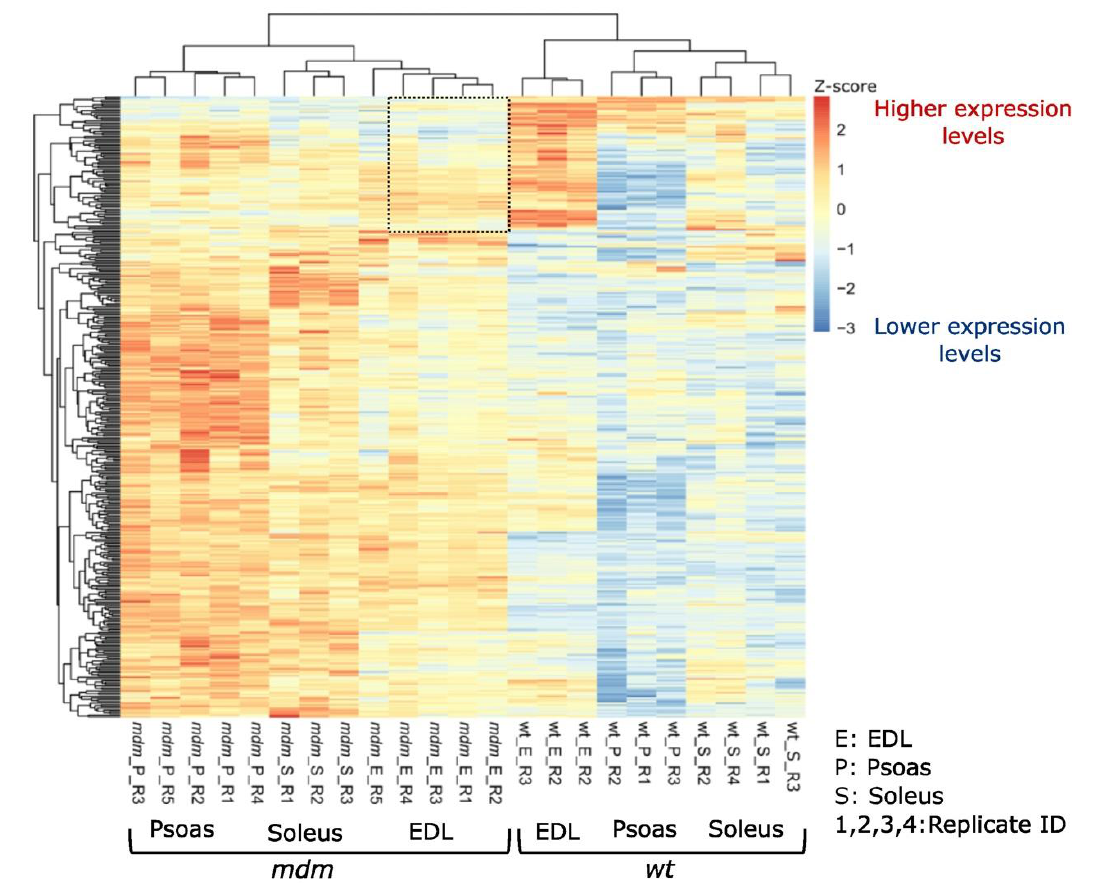
Figure 5. Gene expression changes in ECM-associated genes in mdm skeletal muscles compared to WT muscles. The expression heatmap was generated using ECM-associated differentially expressed genes identified from the RNA sequencing data. The heatmap was generated using Z-scores calculated for each gene in each muscle using variance-stabilized transformed expression levels. Regions containing downregulated genes in mdm EDL muscles compared to WT EDL are highlighted with dotted lines.